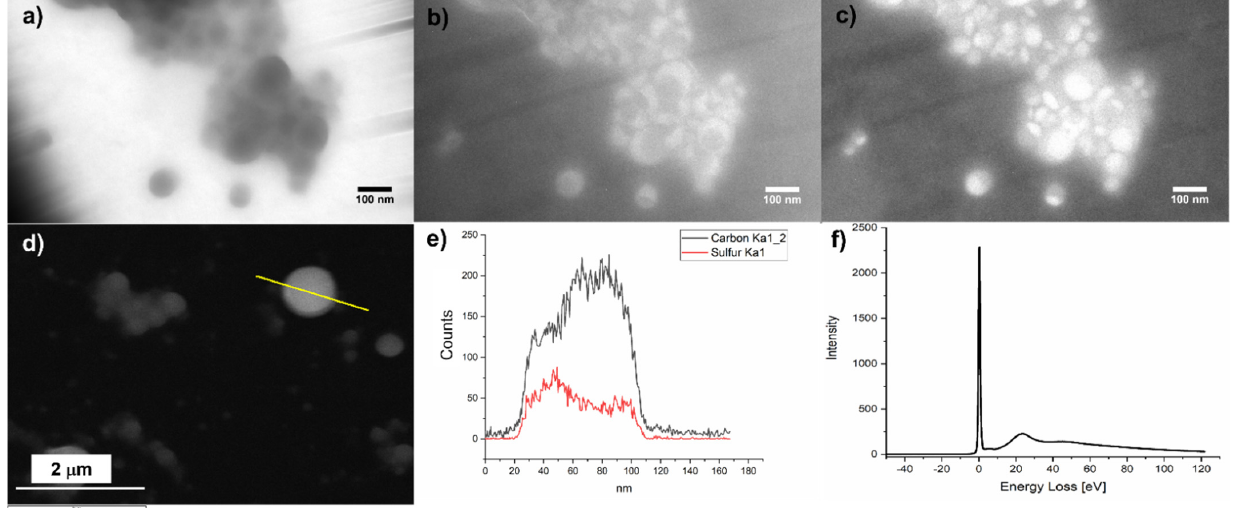
Figure 4. PC 71 BM:PTB7 ‐ b ‐ P4VP (1.1:1) blend WPNPs images and microanalysis. ( a ) CTEM image; ( b ) EFTEM image at 17 eV (the domain containing PC 71 BM is darker); ( c ) EFTEM at 30 eV (the domain containing PC 71 BM is lighter); and ( d ) STEM image. The yellow line indicates the line scan used to collect the EDX line scan map reported in ( e ); and ( f ) low ‐ loss EELS spectrum.